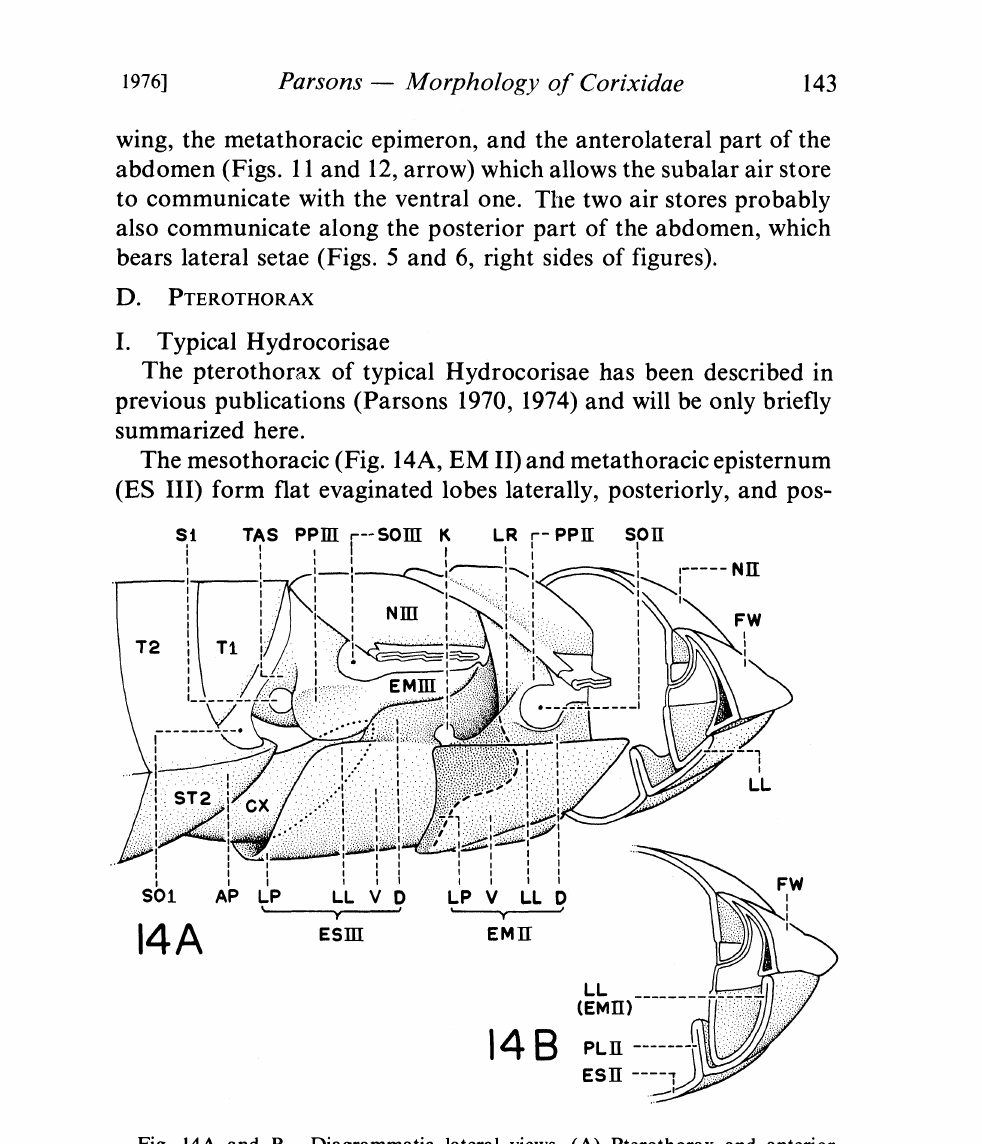
Fig. 14A and B. Diagrammatic lateral views. (A) Pterothorax and anterior abdomen of typical Hydrocorisae. Mesothorax cut transversely, wings removed posterior to transverse cut. Heavy broken line indicates position of lateral inter- segmental boundary, concealed by external wall of mesothoracic epimeron (EM II); heavy stippling indicates intersegmental air store, which contains metathoracic spiracle (concealed in this view). (B) Anterior mesothorax, cut as in Fig. 14A, show- ing how lateral epimeral lobe (LL) is modified in M. sedula and H.